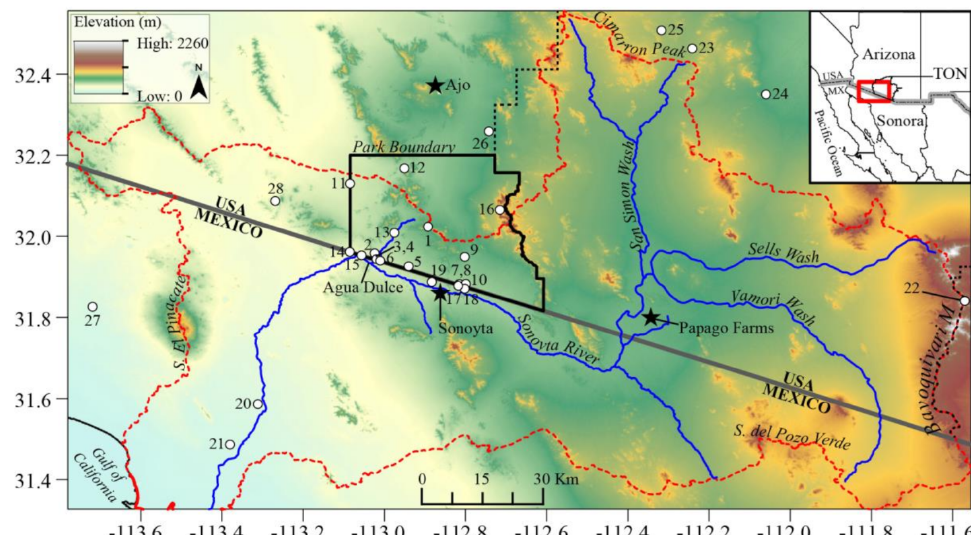
Figure 1. Sonoyta River Watershed (delimited by red-dotted line) and major geographical features in the region. Black dashed line shows the limits of the Tohono O’odham Nation (TON). Black bold line shows the limit of the Organ Pipe Cactus National Monument (OPCNM). Sample sites (white circles) are identified by numbers listed in Table 1. Black star symbols show the towns of Ajo, Arizona, Sonoyta, Sonora, and the Papago Farms in the